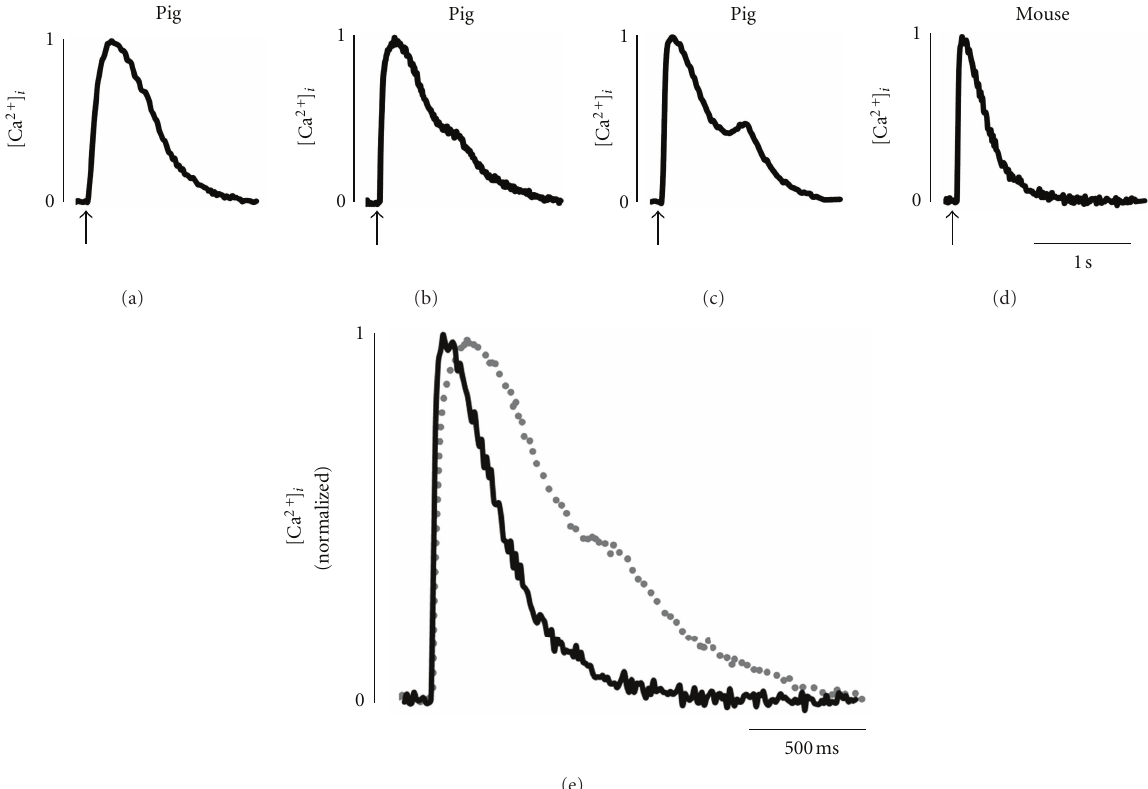
Figure 8: Representative amplitude-normalized calcium transients of Pig ((a)–(c)) and Mouse (d) left-ventricular myocytes (0.5Hz, field stimulus denoted by arrow). Calcium transients from Pig exhibited multiple waveforms, including normal recovery from the transient peak (a, 2 of 14 cells), recovery with a marked shoulder ((b), 8 of 14 cells), and recovery with a secondary increase in calcium (c, 4 of 14 cells). (d) Mouse transients consistently exhibited a rapid transient recovery ( n = 40). (e) Overlay of transients shown in (b) and (d) illustrating the distinct transient kinetics between pig (gray) and mouse (black)